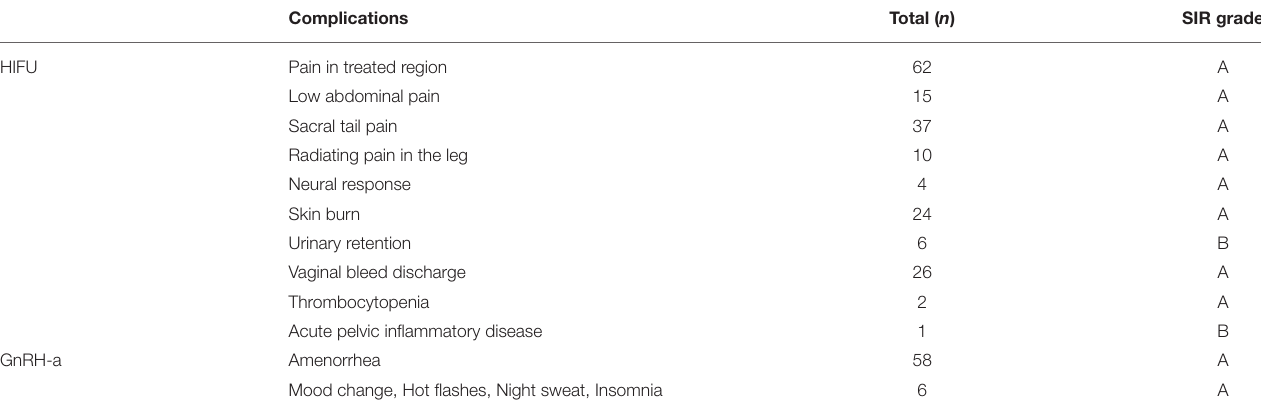
TABLE 2 | Adverse reactions occurred in the patients after